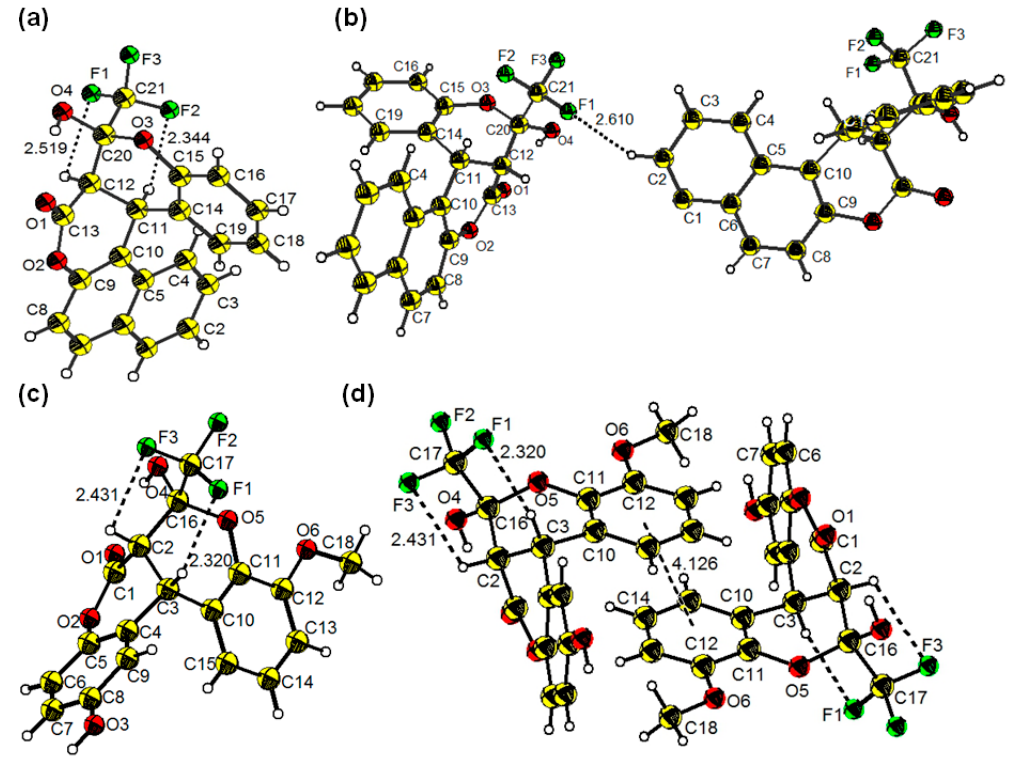
Figure 1. Thermal ellipsoid (30%) drawings of compound 3a ( a ); packing of the crystal structure of 3a ( b ); thermal ellipsoid (30%) drawings of compound 3n ( c ); and intermolecular hydrogen bonding of compound 3n ( d ). Note: yellow, carbon; white, hydrogen; red, oxygen; green, fluorine.